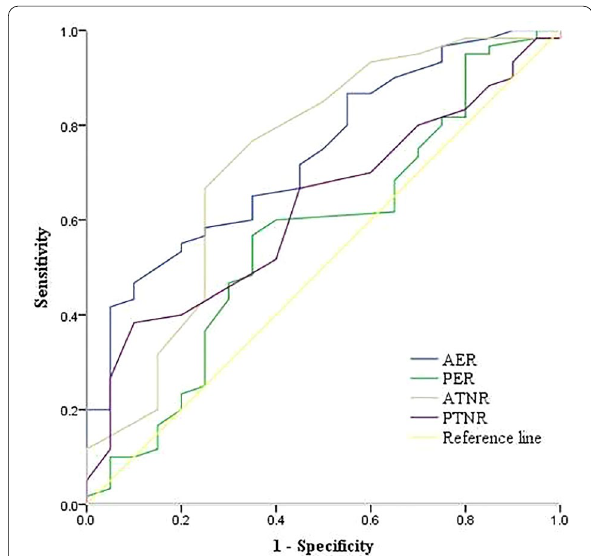
Fig. 7 ROC curves for the arterial enhancement ratio (AER), portal enhancement ratio (PER), arterial tumour to normal parenchyma ratio (ATNR), and portal tumour to normal parenchyma ratio (PTNR). There were significant differences between the arterial enhancement ratio and the arterial tumour to the normal parenchyma